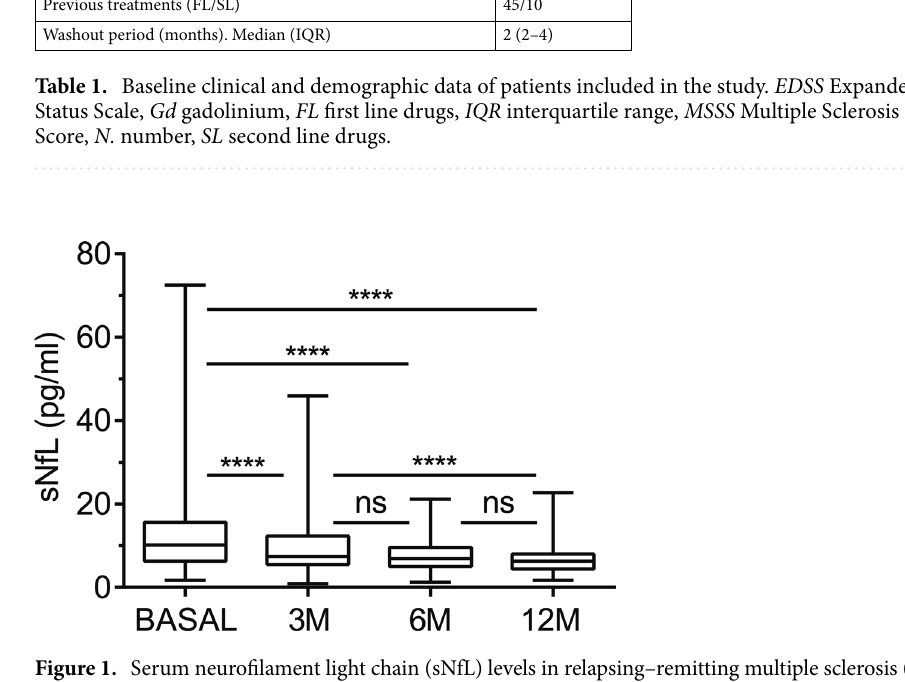
Figure 1. Serum neurofilament light chain (sNfL) levels in relapsing–remitting multiple sclerosis (RRMS) patients. sNfL concentration (median, IQR) obtained in 80 RRMS patients at baseline (Basal) and 3, 6, and 12 months (M) after dimethyl fumarate initiation. **** p < 0.0001; ns not